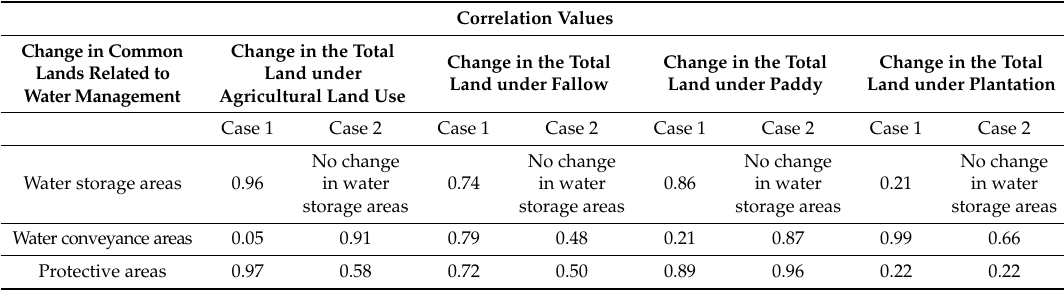
Table 3. Correlation values between change in land under agricultural land use and change in total land area existing as common lands related to water